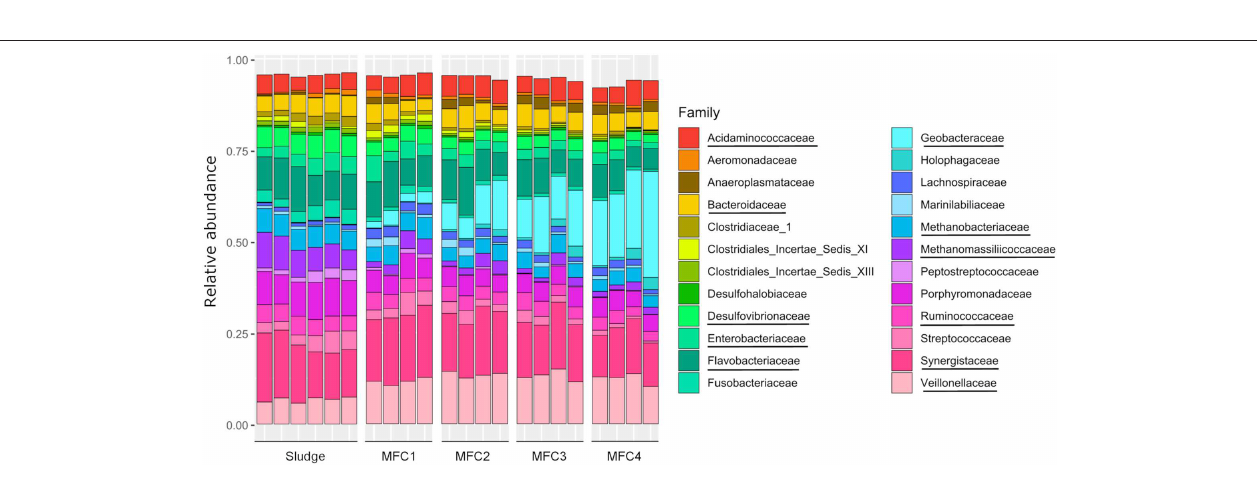
FIGURE 10 | Relative abundance of microbial family. The more abundant taxa are